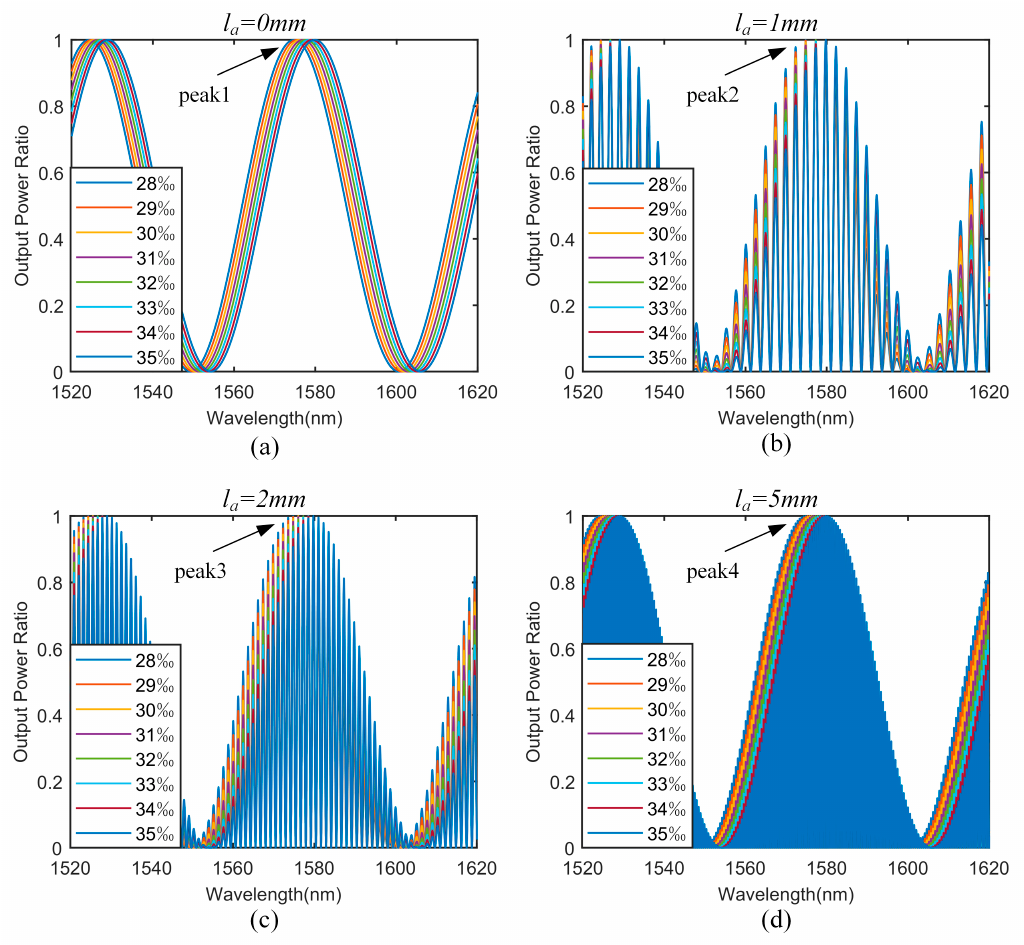
Figure 2. The simulation output spectra with salinities for OMCI arm difference ( a ) l a = 0 mm, ( b ) l a = 1 mm, ( c ) l a = 2 mm, and ( d ) l a = 5 mm.